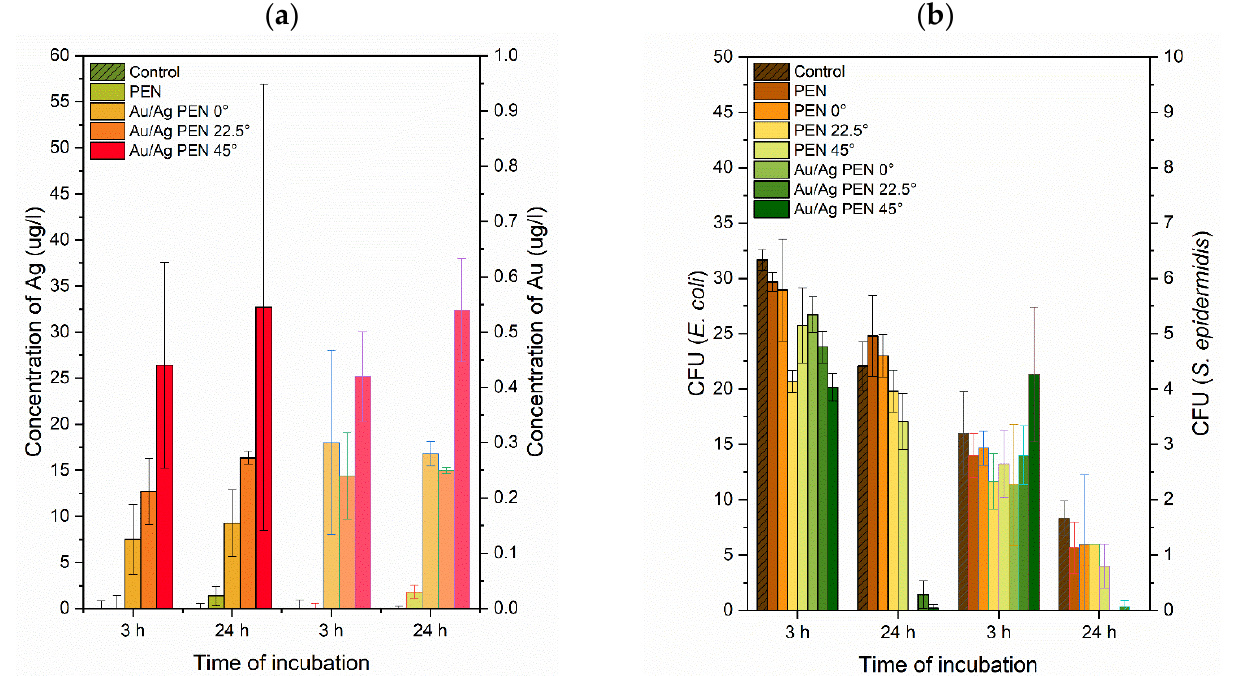
Figure 8. Concentrations of released Au n+ and Ag + ions determined by ICP-MS ( a ) and data from antibacterial tests ( E. coli , S. epidermidis ) performed on PEN, PEN 0/22.5/45 ◦ and Au/Ag PEN 0/22.5/45 ◦ samples compared to control, expressed in CFU values ( b ).